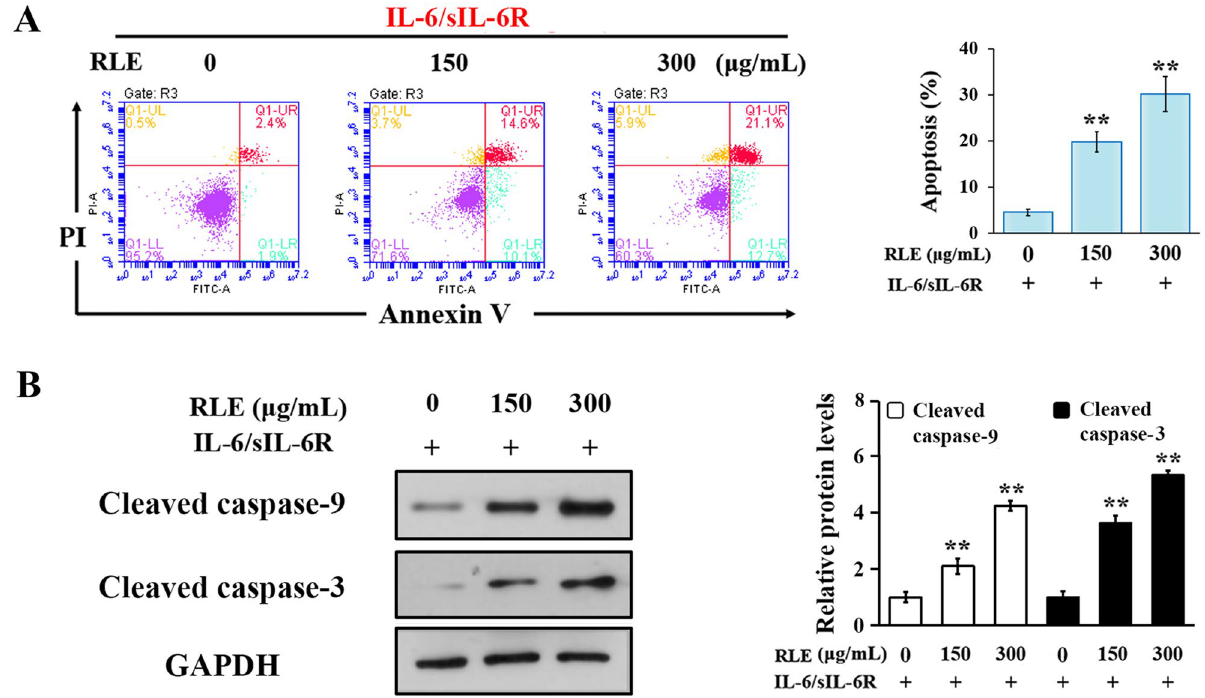
Figure 3. RLE induced apoptosis in RA-FLS. ( A ) RLE induced apoptosis in IL-6/sIL-6R-stimulated synoviocytes. Apoptosis was analyzed by flow cytometry after the cells were stained with Annexin V/PI. Representative scatter graphs are shown in left panels. FITC positive cells (right quadrants) were regarded as apoptotic cells. Quantitative results are shown in the right panel (n = 3). ( B ) RLE increased cleaved caspase-9 and cleaved caspase-3 in IL-6/sIL-6R-stimulated synoviocytes. Cells were pre-treated with indicated concentrations of RLE for 1 h and then treated with IL-6/sIL-6R for 24 h. Protein levels were examined using immunoblotting. Representative blots are shown in the left panel. Protein levels relative to GAPDH were analyzed using ImageJ software and are shown in the right panel (n = 3). In ( A , B ), * P < 0.05, ** P < 0.01 vs. RLE-untreated group.